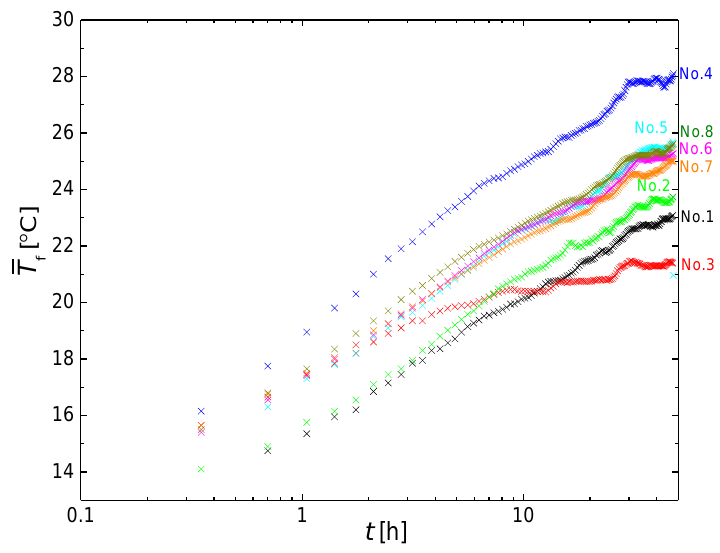
Figure 4. Comparison of brine temperatures during heating at eight BHEs.